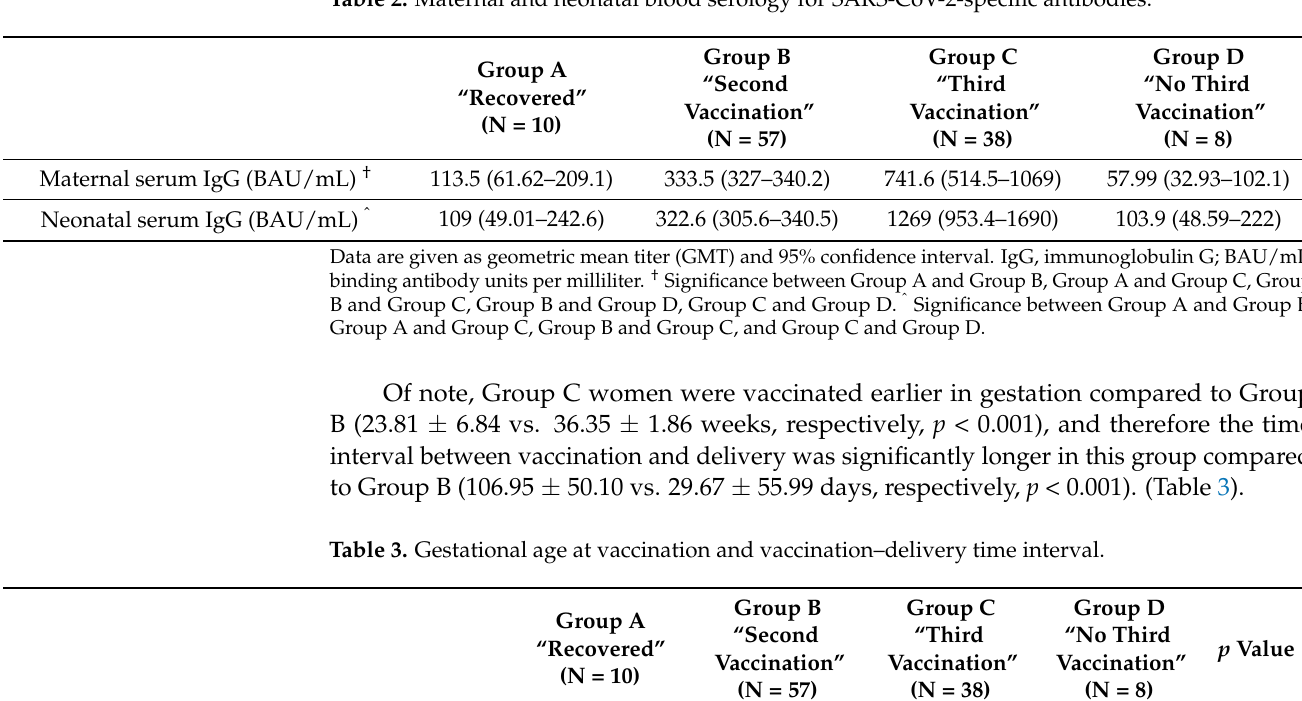
Table 2. Maternal and neonatal blood serology for SARS-CoV-2-specific antibodies.